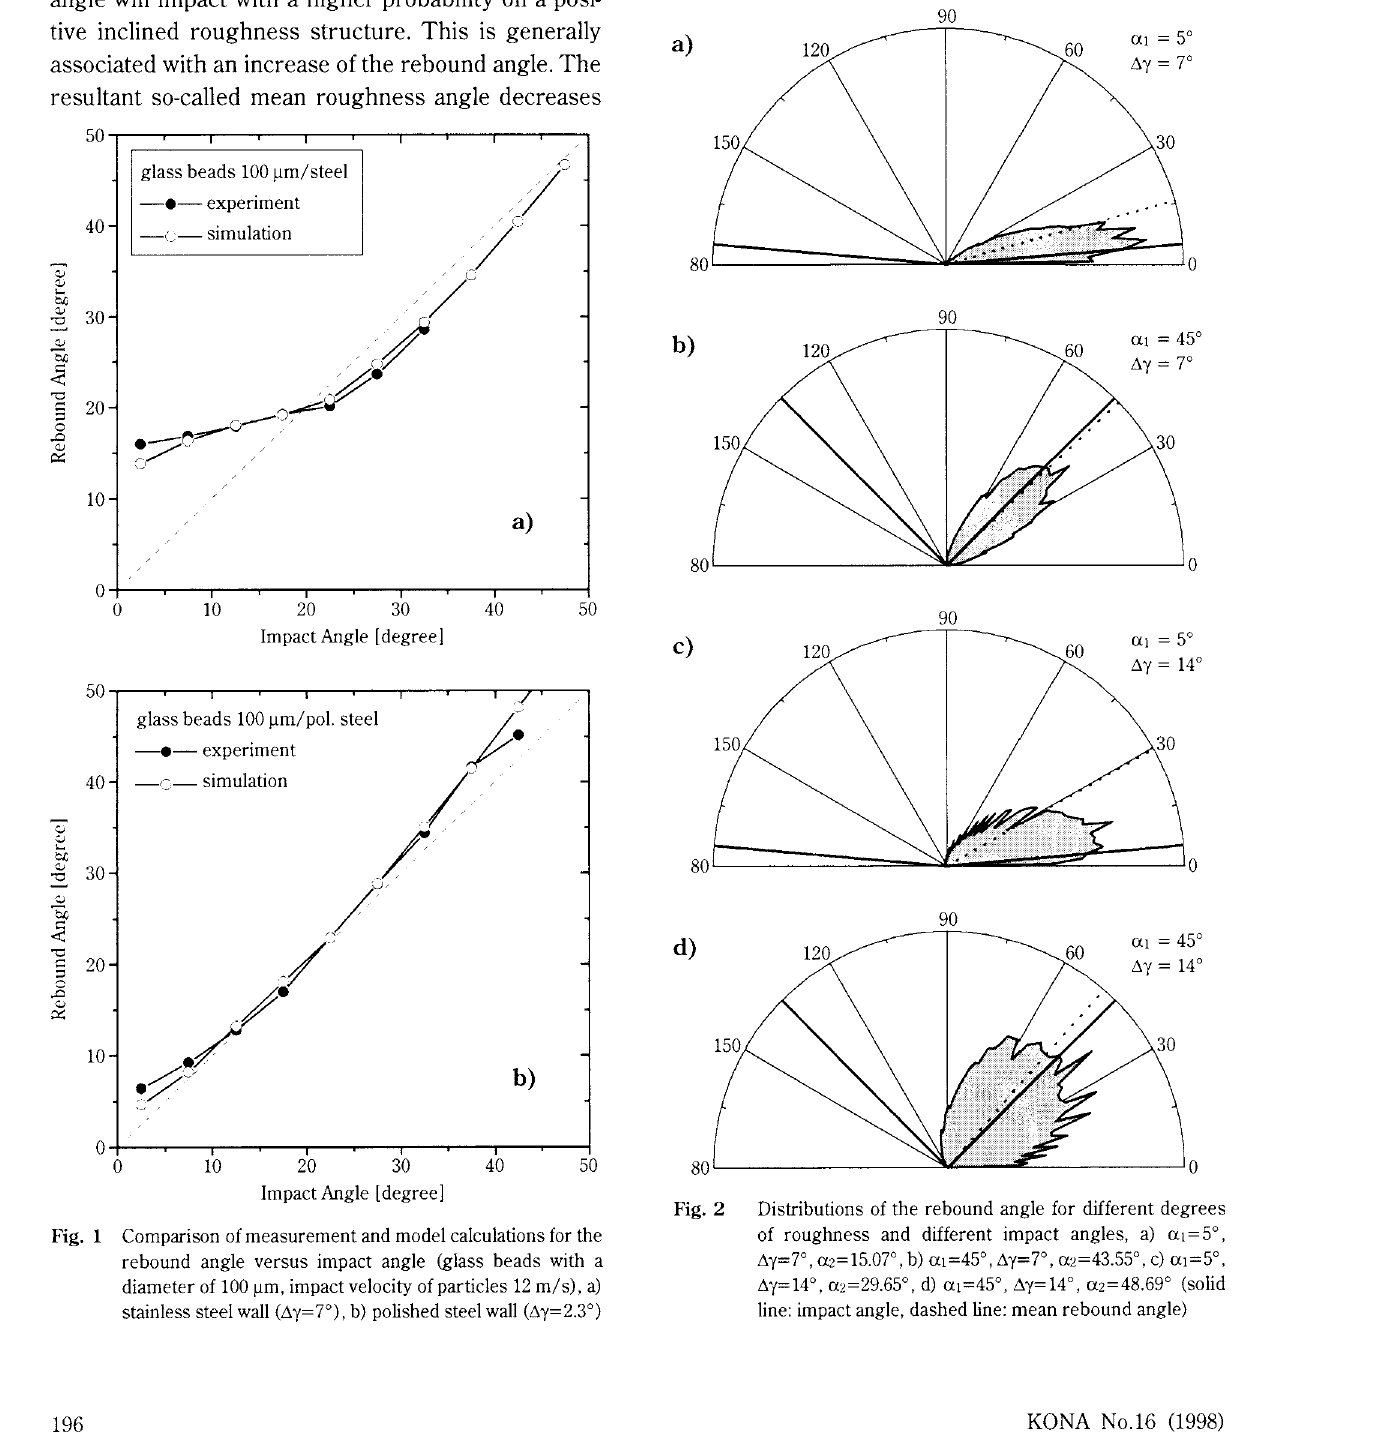
Fig. 2 Distributions of the rebound angle for different degrees of roughness and different impact angles, a) a1 =5°, l':.y=7°, az=15.07°, b) aJ=45°, l':.y=7°, az=43.55°, c) a1=S 0 , l':.y=14°, az=29.65°, d) aJ=45°, l':.y=l4°, az=48.69° (solid line: impact angle, dashed line: mean rebound